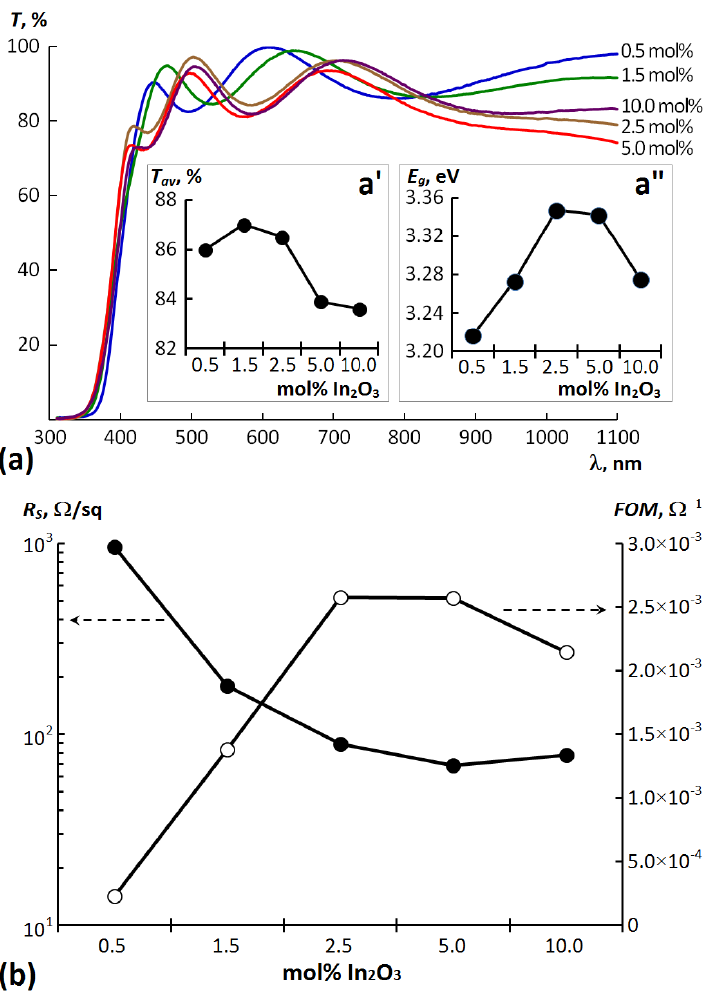
Figure 3. ( a ) Transmittance spectra in the 300–1100 nm region for ZIO thin films deposited by using the targets with various In 2 O 3 content (Inset a’ and Inset a” show the dependences of the average transmittance T av and optical gap Eg of ZIO films on the In 2 O 3 content, respectively); ( b ) Dependences of R S and FOM of the ZIO films on the In 2 O 3 content in the sputtered ceramics. With an increase in the doping level, the average transmittance T av in the visible re- gion (380—760 nm) tends to decrease (see Inset a’ in Figure 3a). This may be due to an